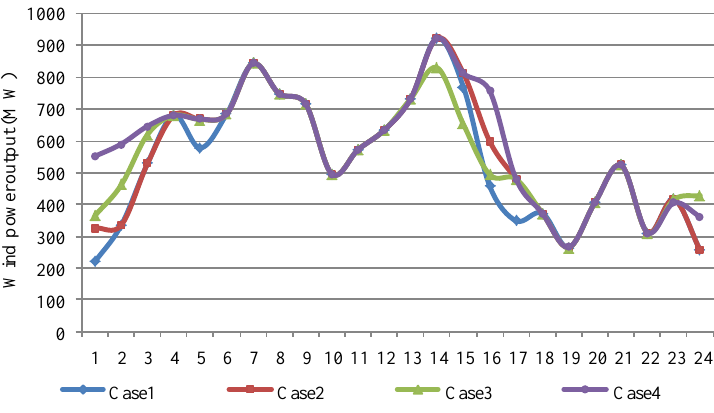
Figure 8. Wind power output in the four